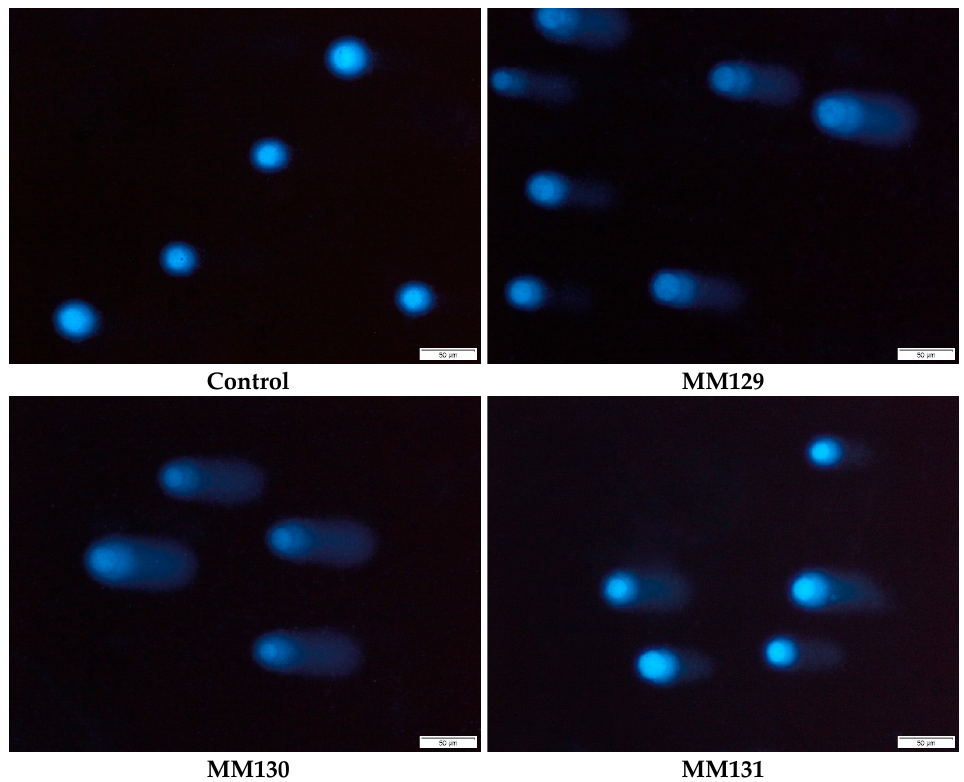
Figure 3. Exemplary images of the comets obtained in the alkaline version of the comet assay after incubation of PC-3 cells with MM129 , MM130 , and MM131 in the concentrations equal to their 2 × IC 50 values. The scale bar is 50 μ m.